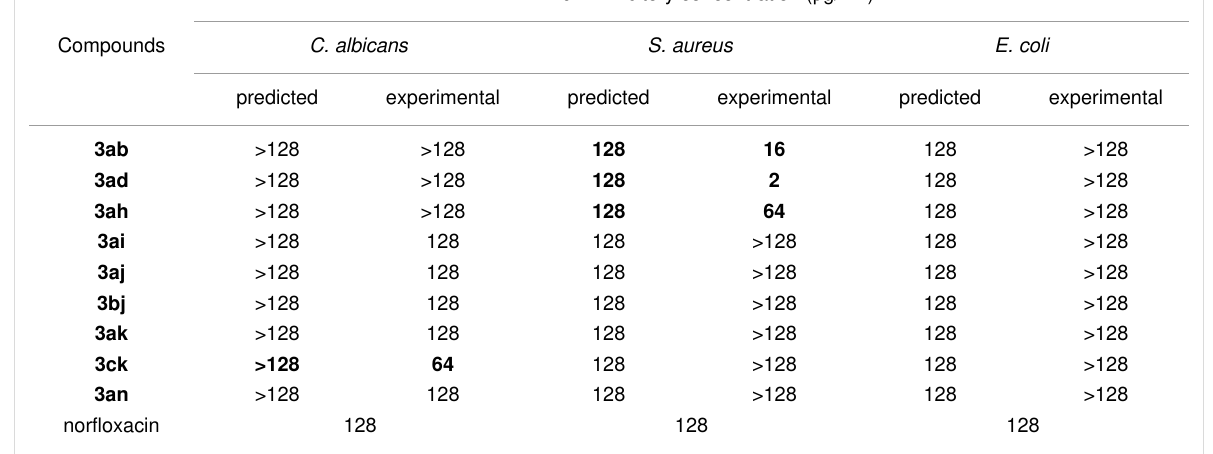
Table 4: Results of antimicrobial activity of synthetic quinoline compounds.